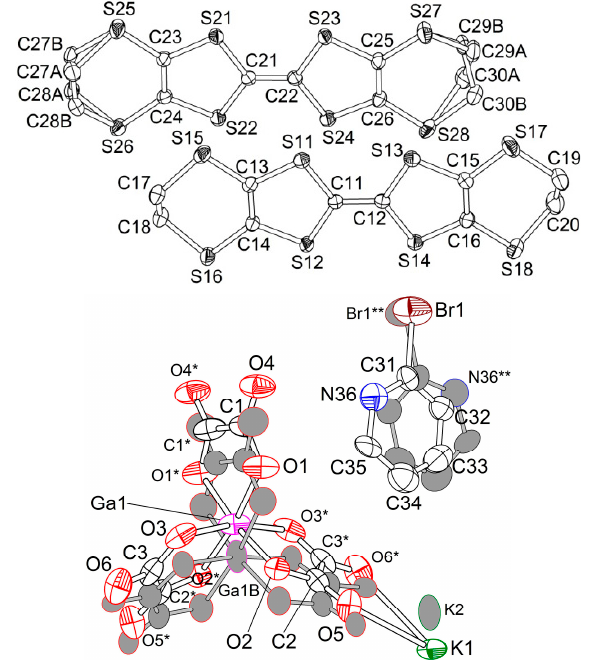
Figure 1. Asymmetric unit in 4 (30% level of thermal ellipsoids). Symmetry codes: (*) (1 − x , y , 1.5 − z ), (**) ( − x , y , 1.5 − z ). Anion [Ga(ox) 3 ] 3 − and cation K + are in the special positions on a two-fold axis, and the solvent is in the general position near a two-fold axis. The K1 site is occupied by a mixture of K + /H 3 O + cations in a ratio of 0.60/0.20 in 1 and 4 , 0.56/0.20 in 2 and 0.68/0.20 in 3 . There is a second independent position of the anion and K + cation (grey color) with occupancy of Cr1B(Ga1B)/K2 sites of 0.25/0.20 in 1 and 4 , 0.32/0.24 in 2 and 0.12/0.12 in 3 .